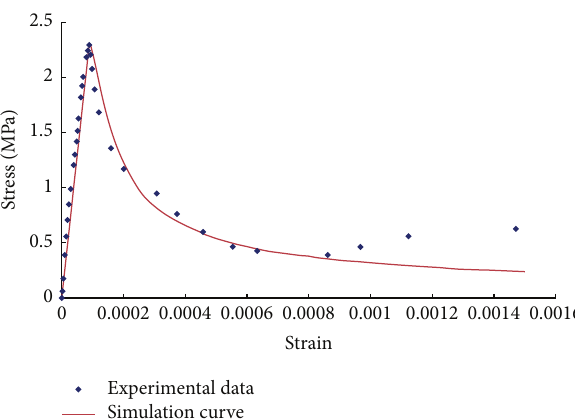
Figure 5: Comparison of stress-strain relationship between numer- ical simulation and experimental tests for specimen A1.